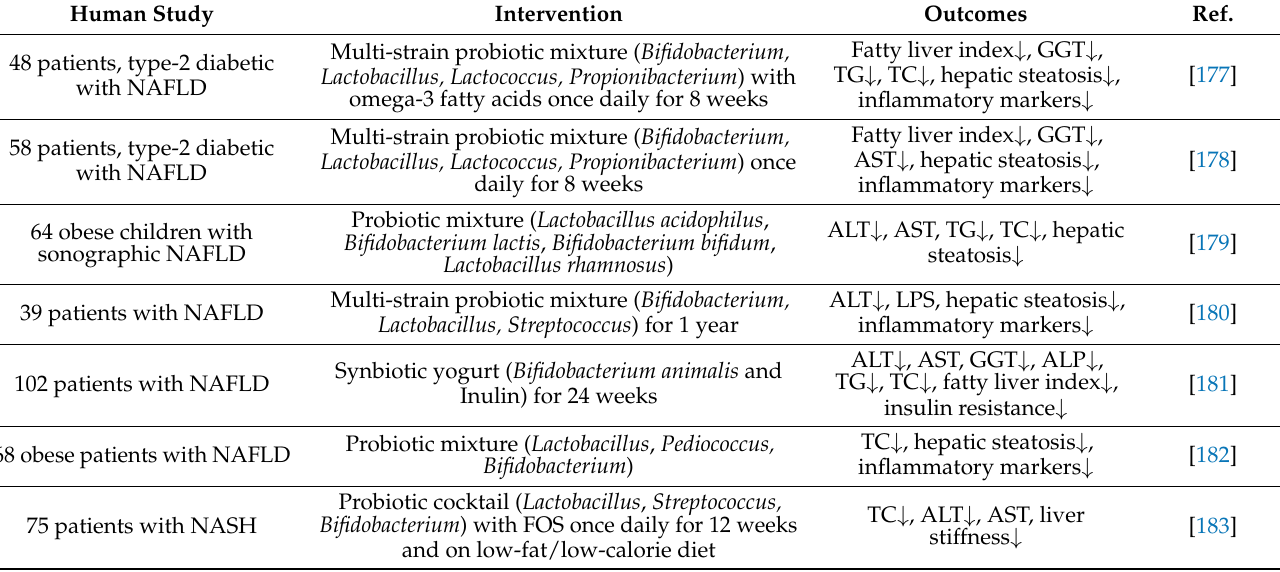
Table 2. Microbiota-based clinical studies in non-alcoholic fatty liver